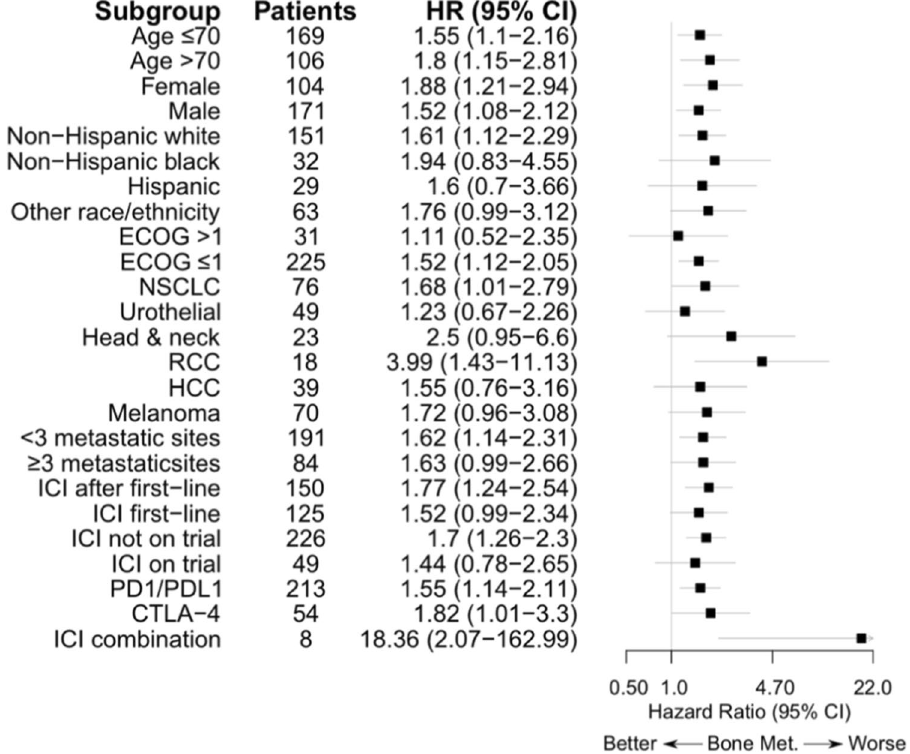
Figure 1. Association of Bone Metastases with PFS across Clinical